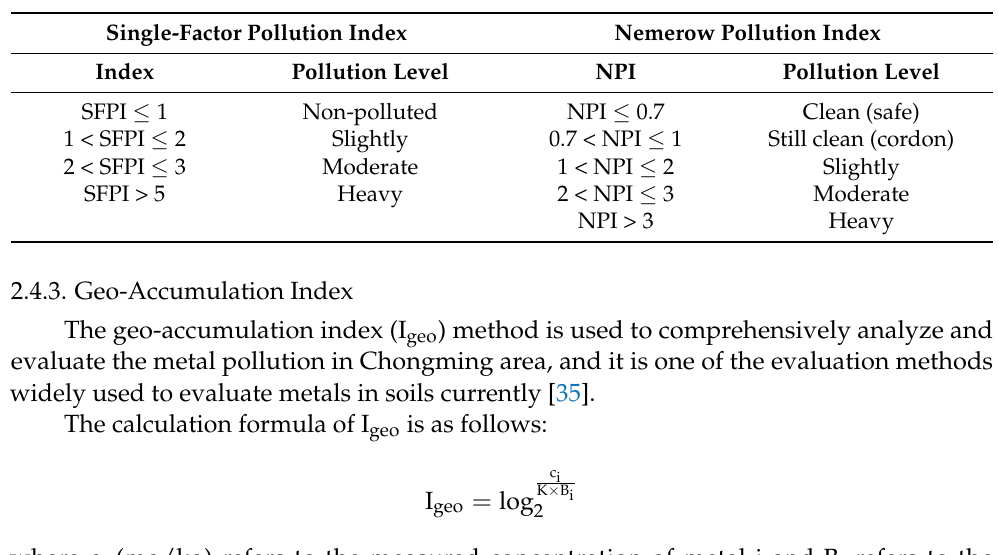
Table 1. The standard of single-factor pollution index and Nemerow pollution